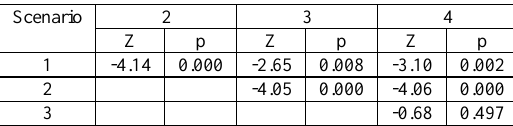
Table 2. Wilcoxon signed-rank test results (dominant hand)